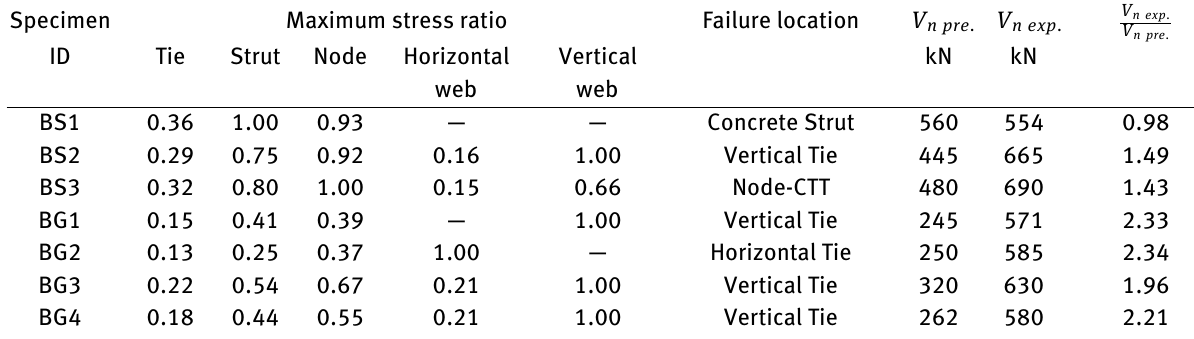
Table 10: Cast ultimate capacity according to ACI 318-19 Specimen